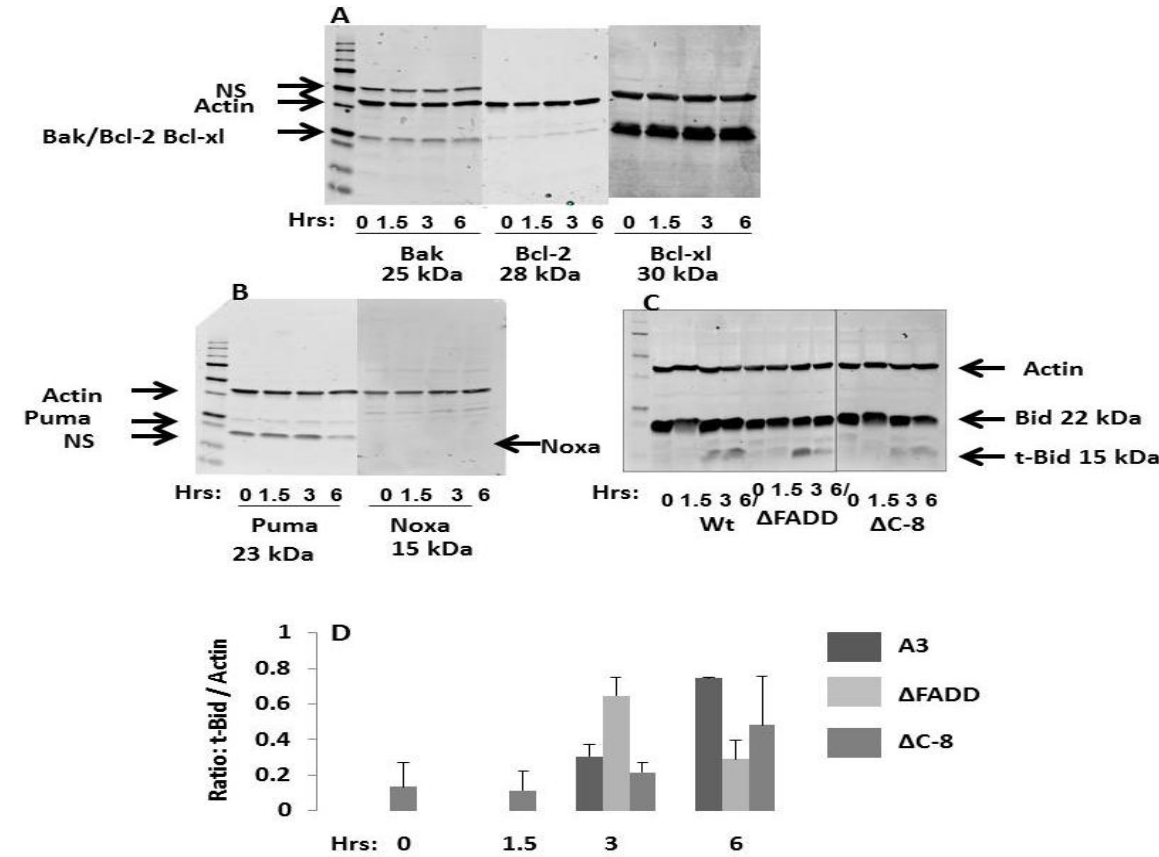
Figure 8. NsPEFs induce Bid cleavage in a time-dependent manner in Jurkat cells. Cells were sham treated or exposed to ten 60 ns pulse at 60 kV/cm. Samples were prepared for (cid:76)(cid:80)(cid:80)(cid:88)(cid:81)(cid:82)(cid:69)(cid:79)(cid:82)(cid:87)(cid:3) (cid:68)(cid:81)(cid:68)(cid:79)(cid:92)(cid:86)(cid:76)(cid:86)(cid:3) (cid:68)(cid:87)(cid:3) (cid:76)(cid:81)(cid:71)(cid:76)(cid:70)(cid:68)(cid:87)(cid:72)(cid:71)(cid:3) (cid:87)(cid:76)(cid:80)(cid:72)(cid:86)(cid:3) (cid:68)(cid:73)(cid:87)(cid:72)(cid:85)(cid:3) (cid:83)(cid:88)(cid:79)(cid:86)(cid:76)(cid:81)(cid:74)(cid:17)(cid:3) (cid:40)(cid:91)(cid:87)(cid:85)(cid:68)(cid:70)(cid:87)(cid:86)(cid:3) (cid:11)(cid:24)(cid:19)(cid:3) (cid:541)(cid:74)(cid:3) (cid:83)(cid:85)(cid:82)(cid:87)(cid:72)(cid:76)(cid:81)(cid:12)(cid:3) (cid:90)(cid:72)(cid:85)(cid:72)(cid:3) separated by SDS-PAGE, transferred to PVDF membranes and probed with antibodies against various antigens (in kDa) A ) . Bak (25), Bcl-2 (28), Bcl-xl (30) and Actin (45) in the Wt clone; B ). Puma (23), Noxa (15) and Actin (45) in the Wt clone; C ). Bid (22), which also recognized t-Bid (15), and Actin (35) in three indicated clones. D ). Bid and t-Bid from quantified using Odyssey infrared imager, normalized to total Bid levels in control and expressed as the ratio of fluorescence of t-Bid to fluorescence of Actin, a loading control. Values, mean ± SE (n=3) from experiments like that shown in C